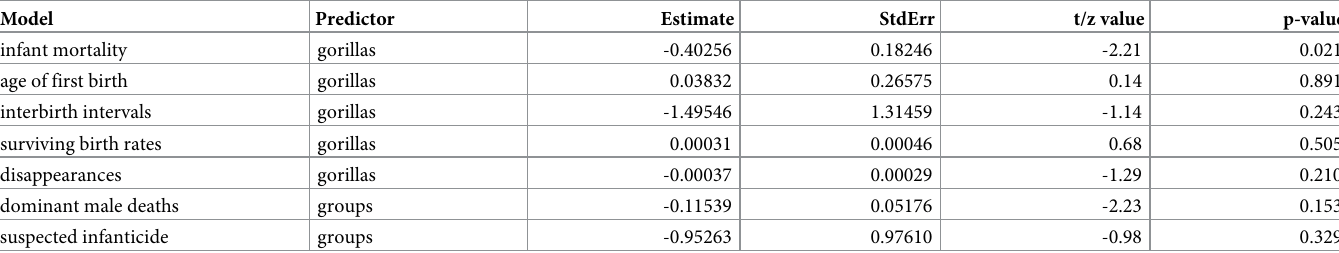
Table 3. Details from statistical models for density